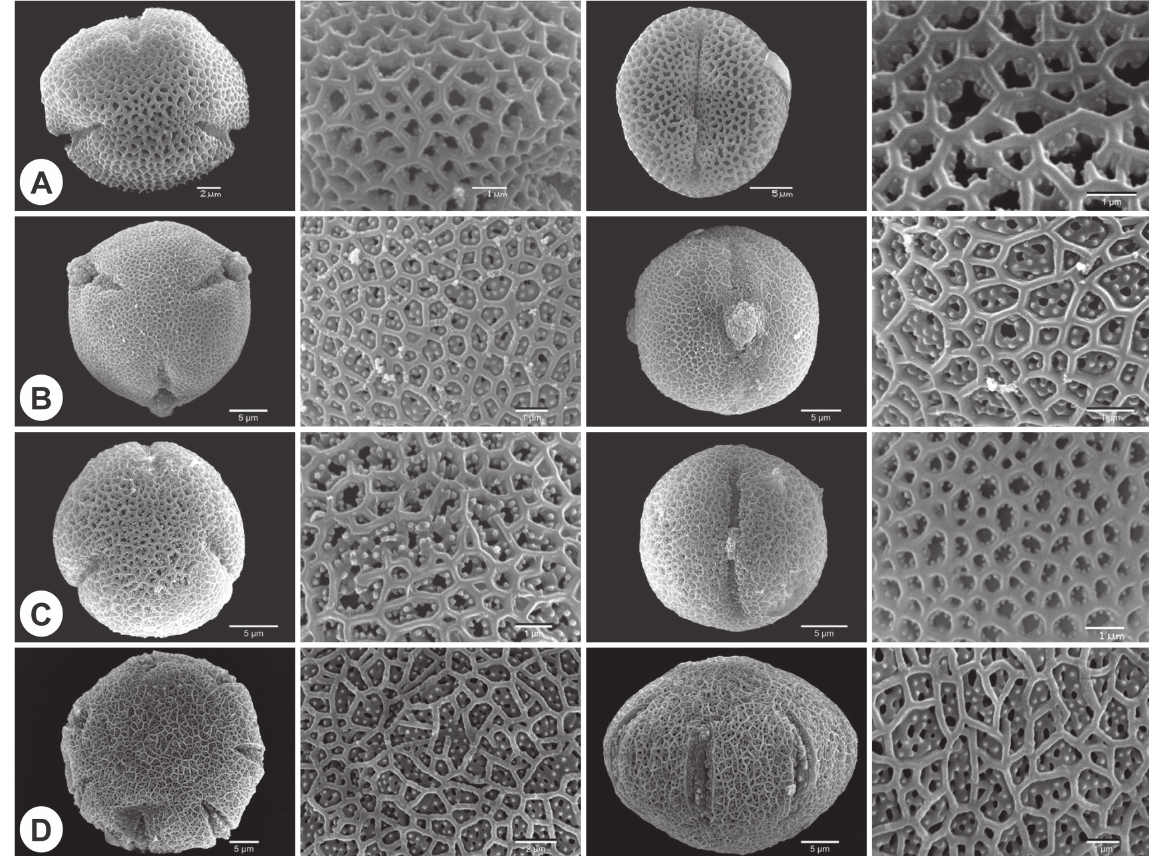
Fig. 11. Scanning electron microscopy micrographs of pollen in polar view (PV), the apocolpium (AC), pollen in equatorial view (EV) and the mesocolpium (ME). A . Astiella homolleae Groeninckx sp. nov. B . A. latifolia Groeninckx sp. nov. C . A. perrieri Groeninckx sp. nov. D . A. tsaratanensis Groeninckx sp. nov. Scale bars for A: PV = 2 µm, AC, ME = 1 µm, EV = 5 µm; for B and C: PV, EV = 5 µm, AC, ME = 1 µm; for D: PV, EV = 5 µm, AC = 2 µm, ME = 1